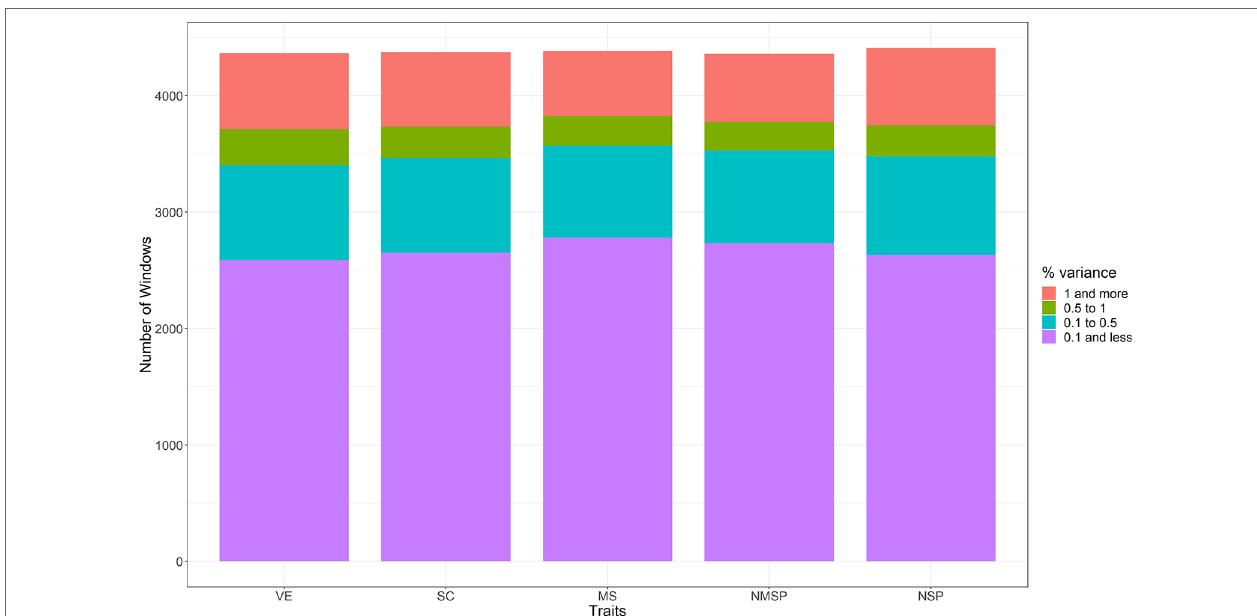
FIGURe 3 | The distribution of the four classes in five semen traits (the regions explained genetic variance: >1%, 0.5%–1%, 0.1%–0.5%, and <0.1%. VE, ejaculate volume; SM, progressive sperm motility; SC, sperm concentration; NSP, number of sperm per ejaculate; NMSP, number of motile sperm).